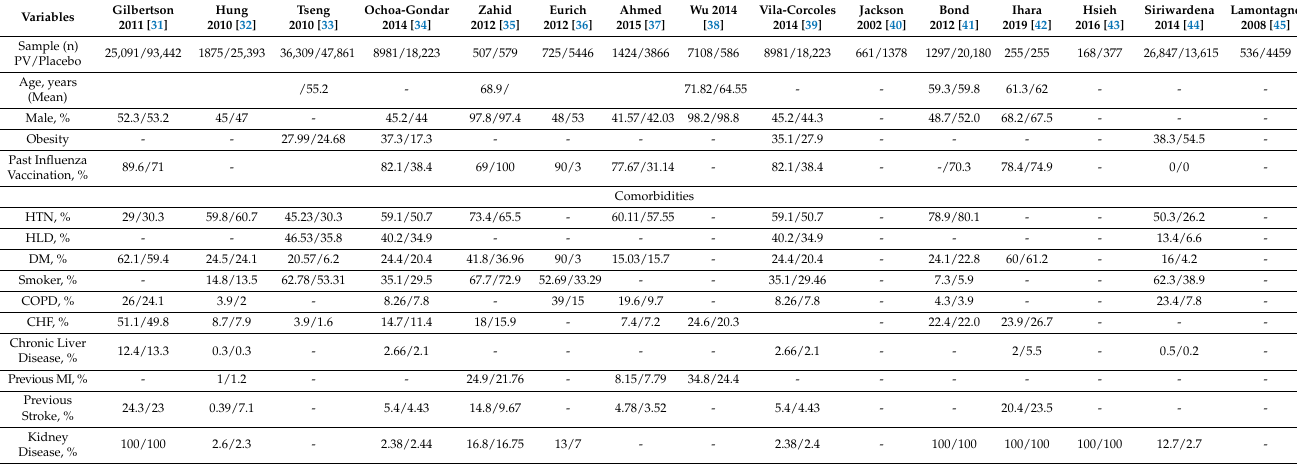
Table 2. Baseline patient demographics and comorbidities *.